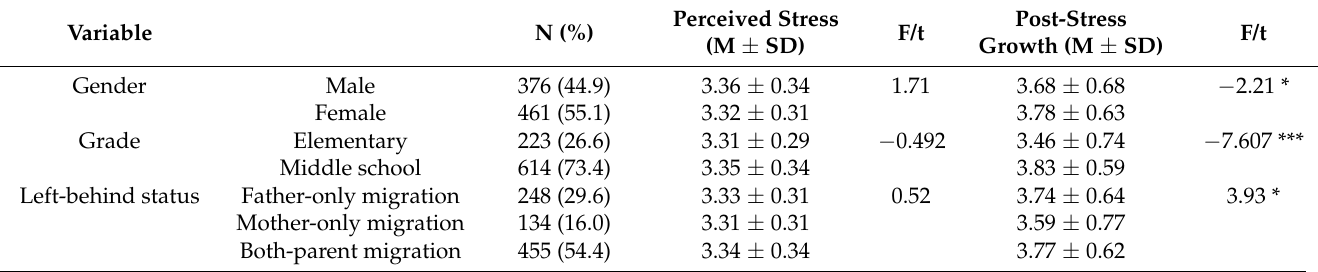
Table 1. Demographics of the study population and association with perceived stress and post-stress growth ( n =